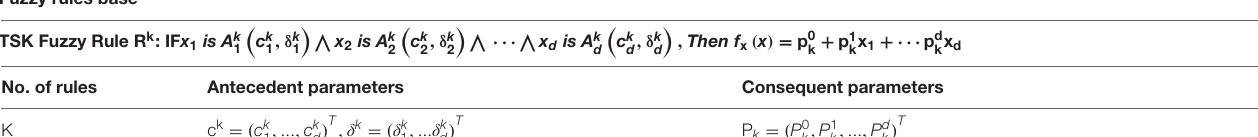
TABLE 9 | TSK-TL Model with five rules trained on the dataset D2 for the KPCA view. Fuzzy rules